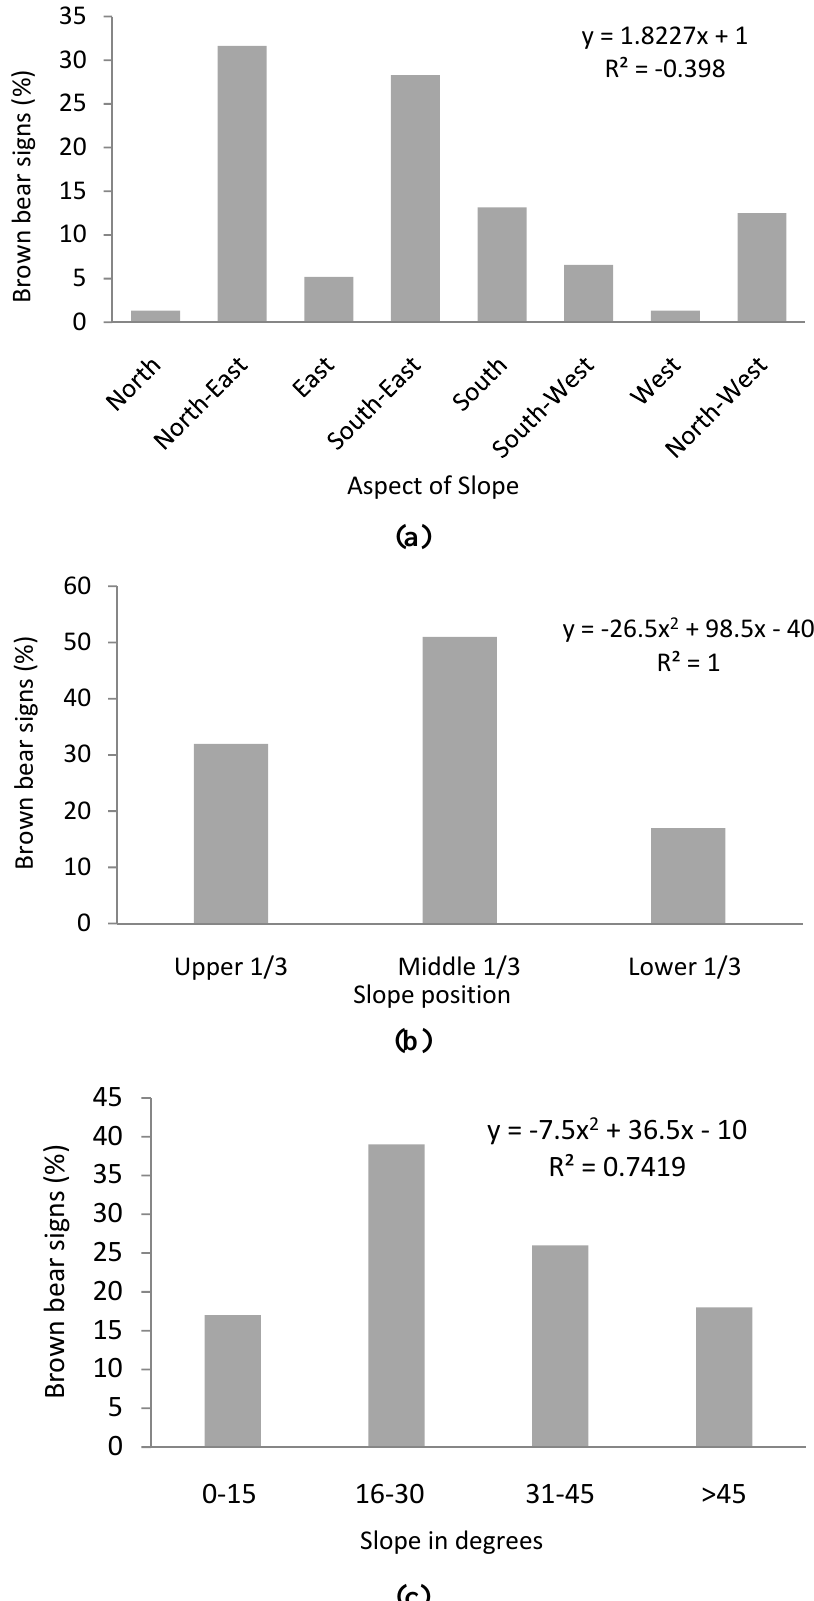
Figure 3. Habitat use by brown bears: ( a ) aspect; ( b ) position on slope relative to river and ridge; ( c ) gradient of